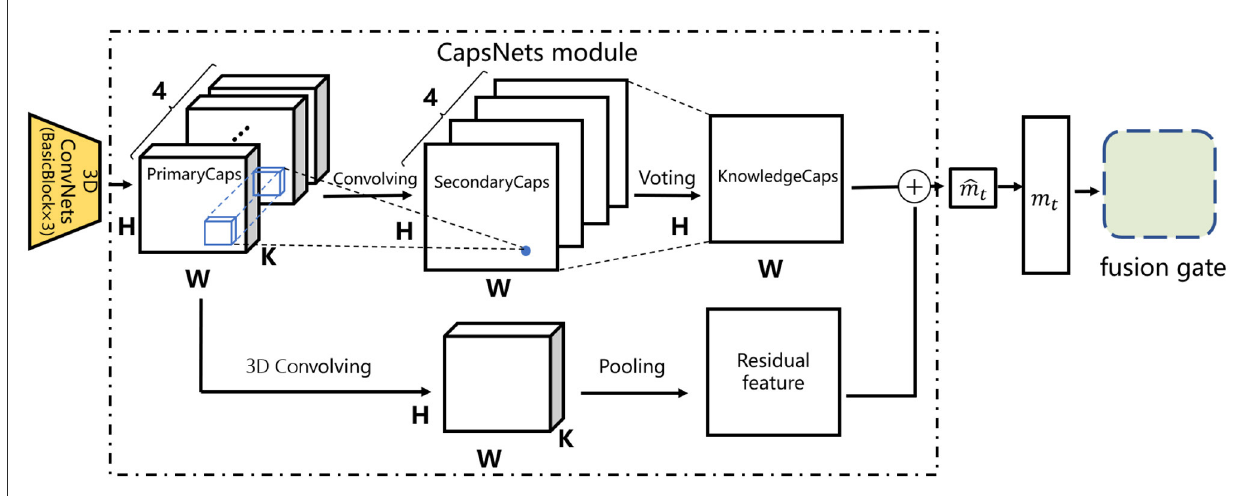
FIGURE4 The architecture of the CapsNets module in the CECAKT model.